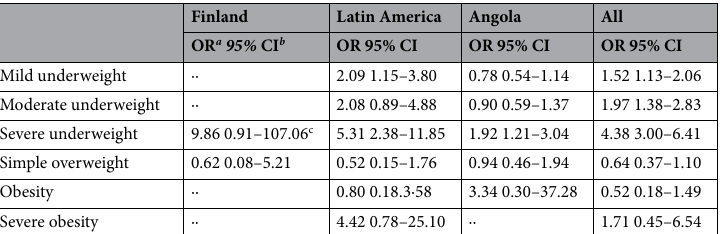
Table 3. Odds of the different degrees of under- or overweight, compared with children with normal weight- for-age, in relation to death in children with bacterial meningitis in Finland, Latin America, and Angola. a Odds ratio. b Confidence intervals. c One of four patients in this category died.